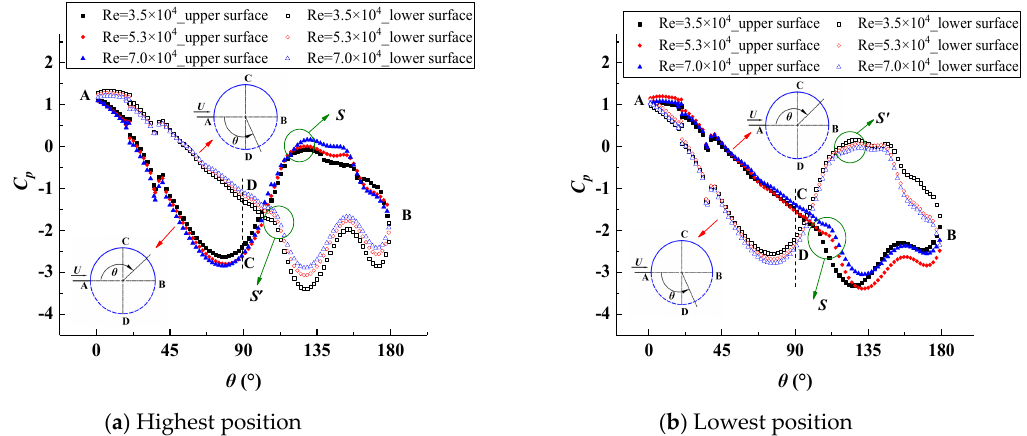
Figure 11. The C p of the PTC cylinder in the flow-induced vibration varied with Re (Z = 5.5 D